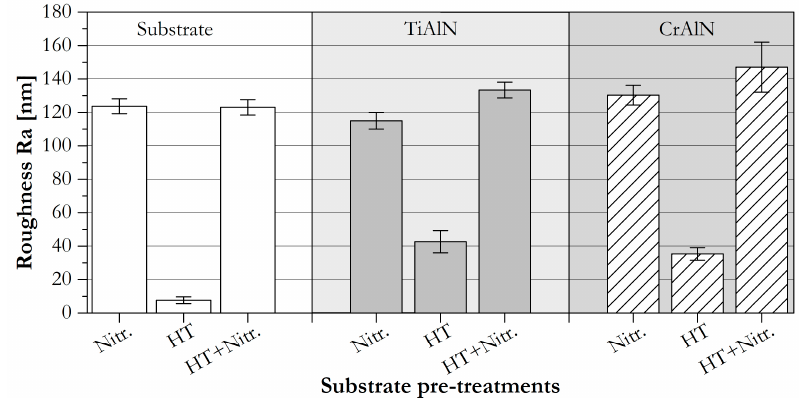
Figure 1. Arithmetic average roughness Ra of the coatings surface and of the substrate after the pre-treatments.